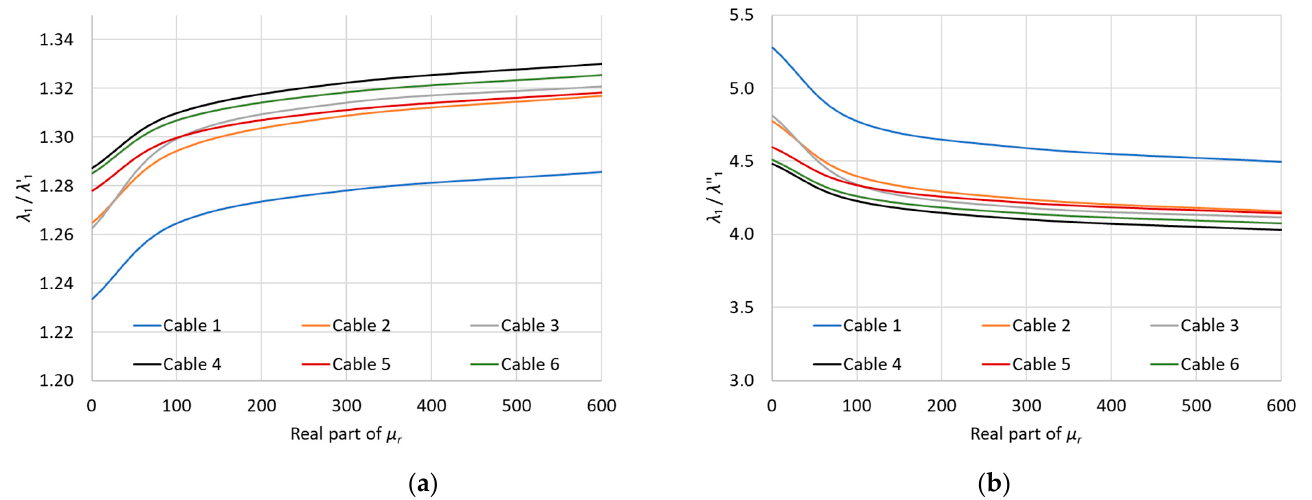
Figure 16. ( a ) λ 1 / λ ’ 1 and ( b ) λ 1 / λ ” 1 against real part of µ r , obtained from FEM simulations for the 6 cables analyzed.